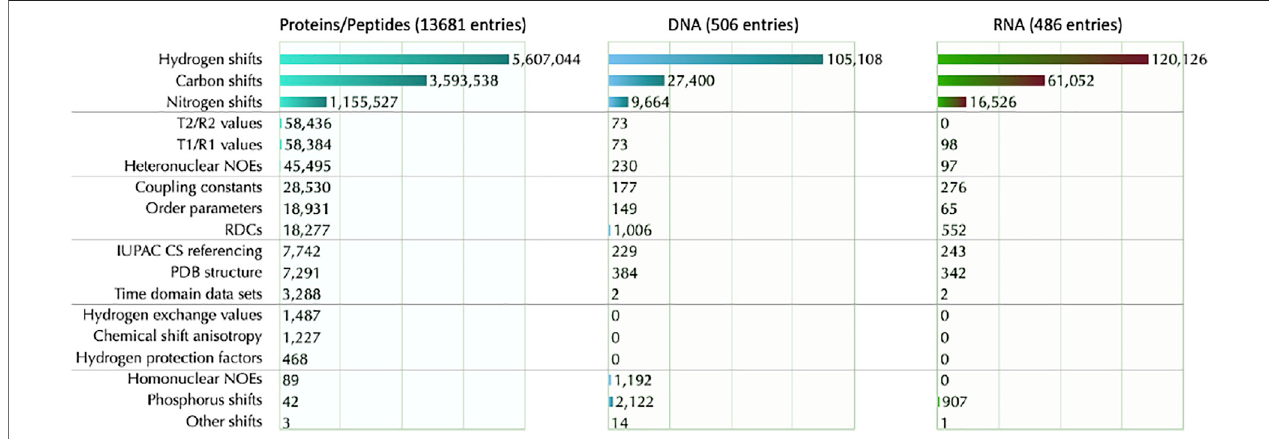
FIGURE5| BMRB datacontent segmentedbymoleculetype and information content.The typeofinformationissegmented into18types and indicated alongthe leftside.Foreachinformationtype,thecountofavailabledataisshowntotherightofthebarinthebargraph.Datawasobtainedondateid2021-W50-4(speci fi edinISO week format indicated as